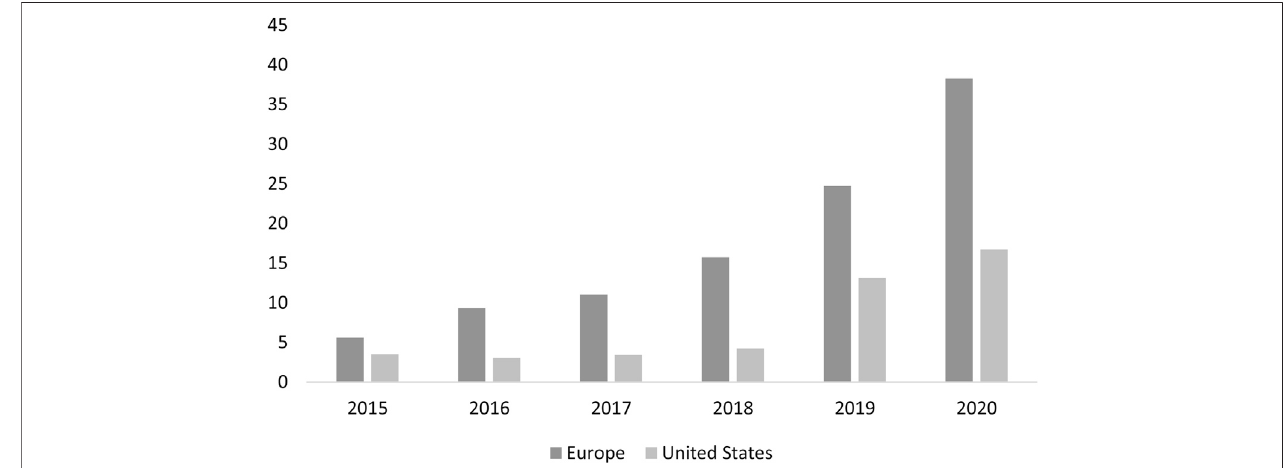
FIGURE 1 | Numbers of EV chargers in Europe and the United States (unit: